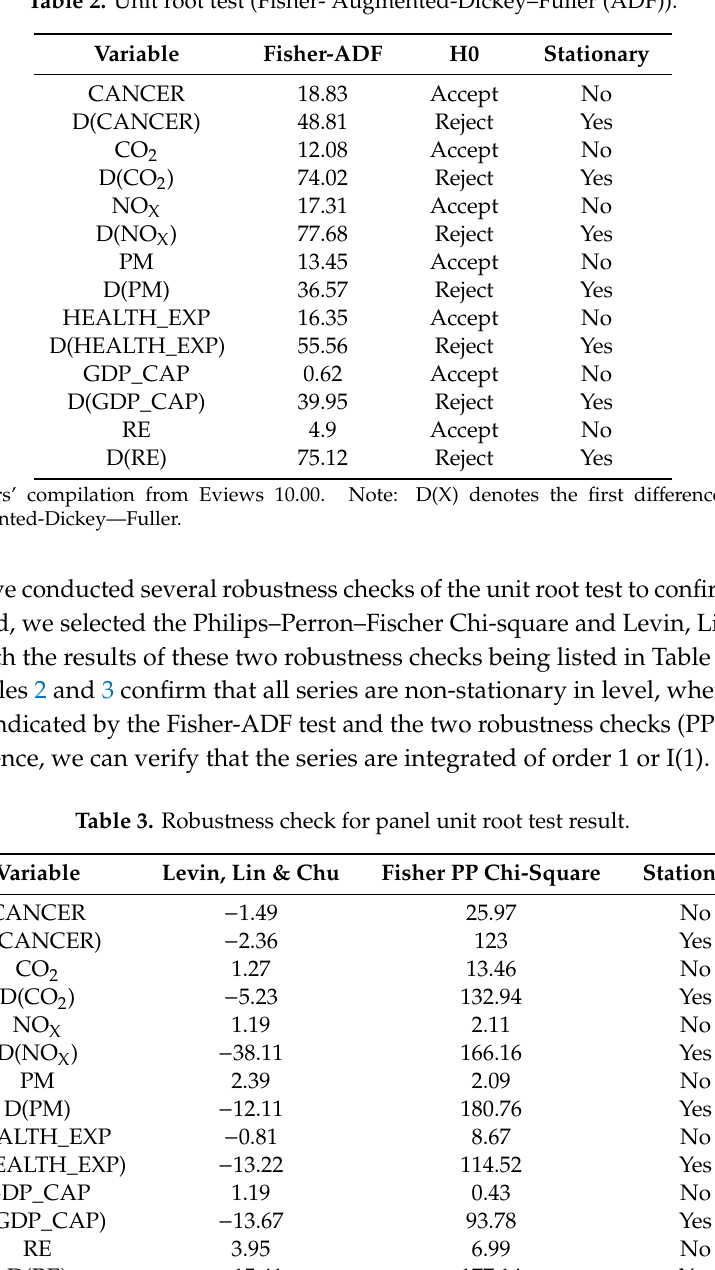
Table 2. Unit root test (Fisher- Augmented-Dickey–Fuller (ADF)).